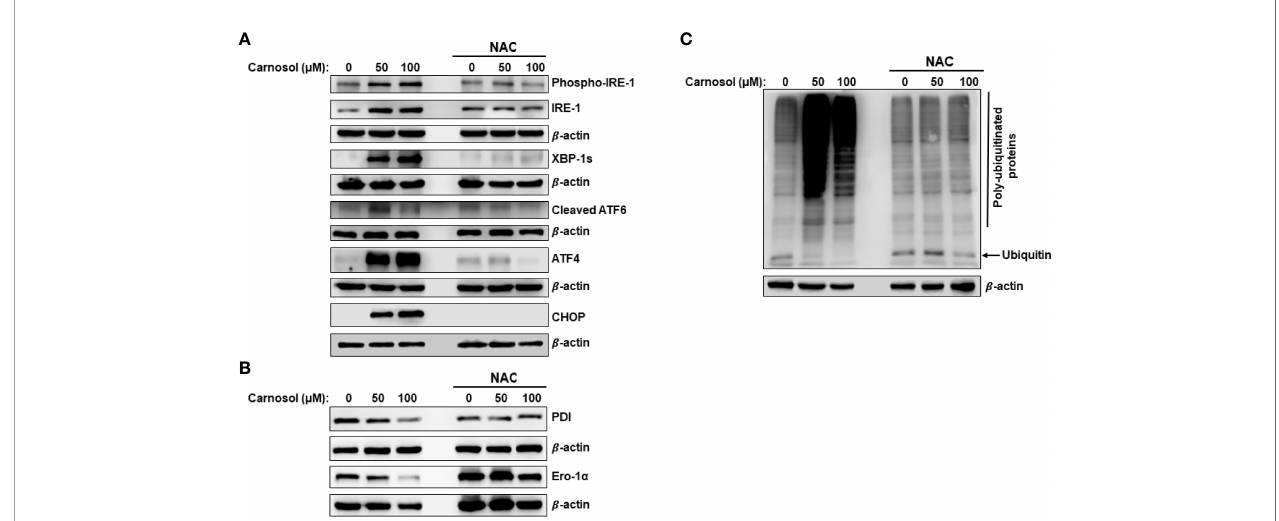
FIGURE 4 | ROS-dependent induction of ER stress and increase in protein ubiquitination. (A, B) ROS-dependent activation of UPR sensors in carnosol-treated MDA-MB-231 cells. Cells were pre-treated with the ROS scavenger NAC (10mM) before adding carnosol at the indicated concentrations for 24 hours. Whole cell lysates were analyzed by Western blot for ER stress markers (A) and protein folding enzymes (B) . (C) Carnosol increases the cellular level of polyubiquitinated proteins in MDA-MB-231 cells. Cells were treated with or without carnosol (50 and 100µM) for 24h, then whole-cell extracts were subjected to Western blot analysis for ubiquitinated